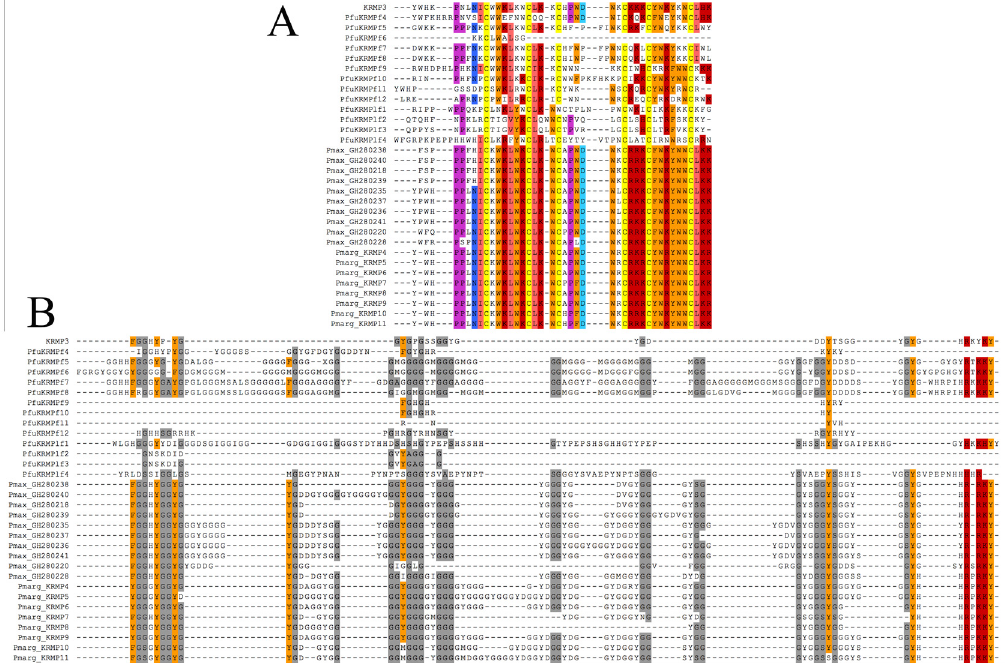
Fig 8. Multiple sequence (except for signal peptide) alignments of KRMP-3 from P . fucata with members from P . margaritifera and P . maxima . They all have two functional regions, a lysine-rich region (A) and a Gly/Tyr-rich region (B). GenBank Accession Numbers of KRMP-4 to KRMP-6 in P . maxima